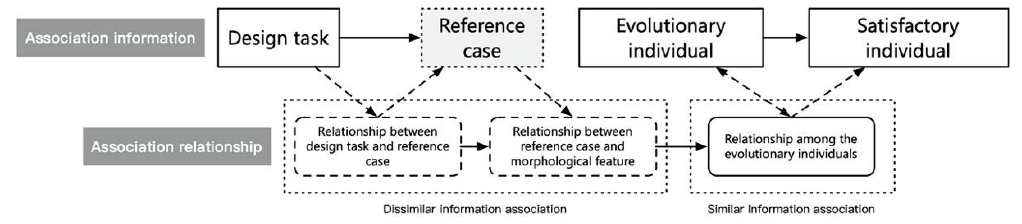
Figure 2. Association of information in the interactive evolutionary design (IED) process for product